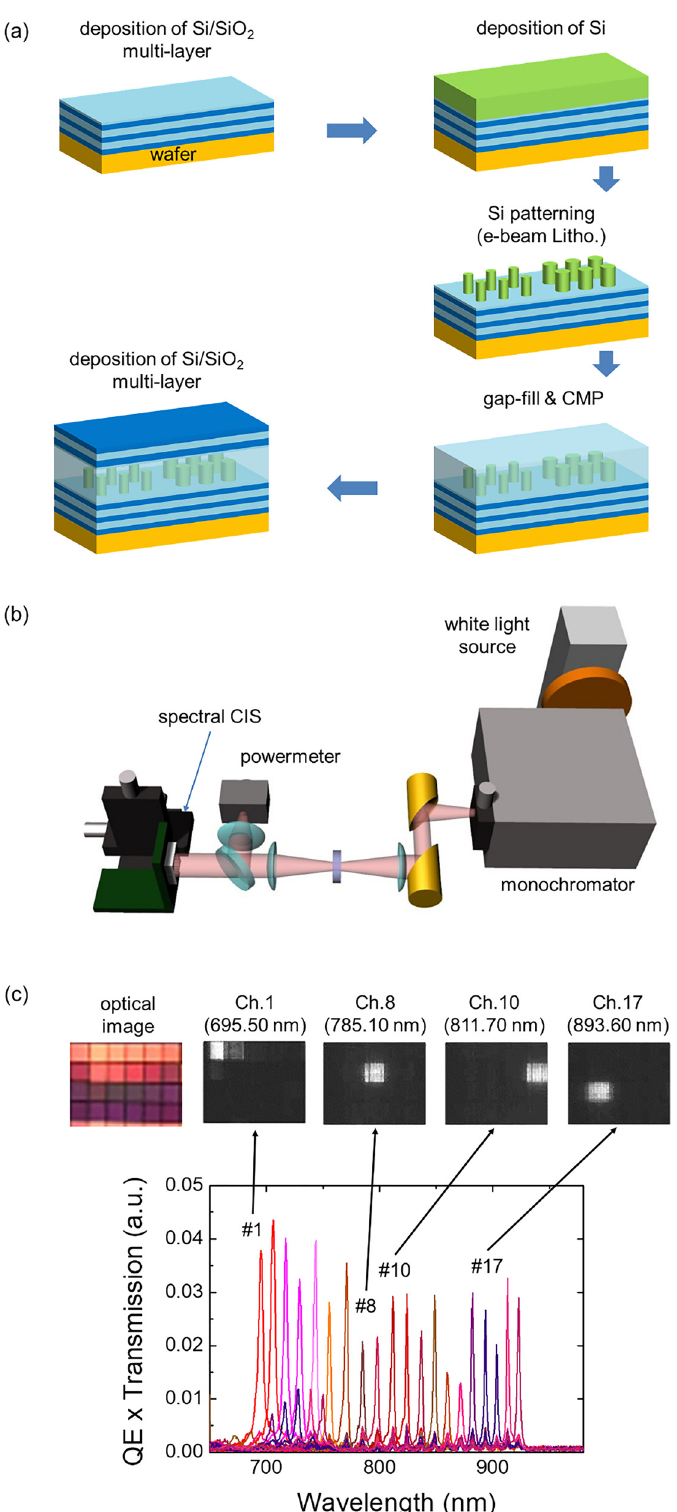
through the output slit. The transmitted light is then divided by a beamsplitter. One is incident into the fabri- cated device and the other is incident into a power-meter to